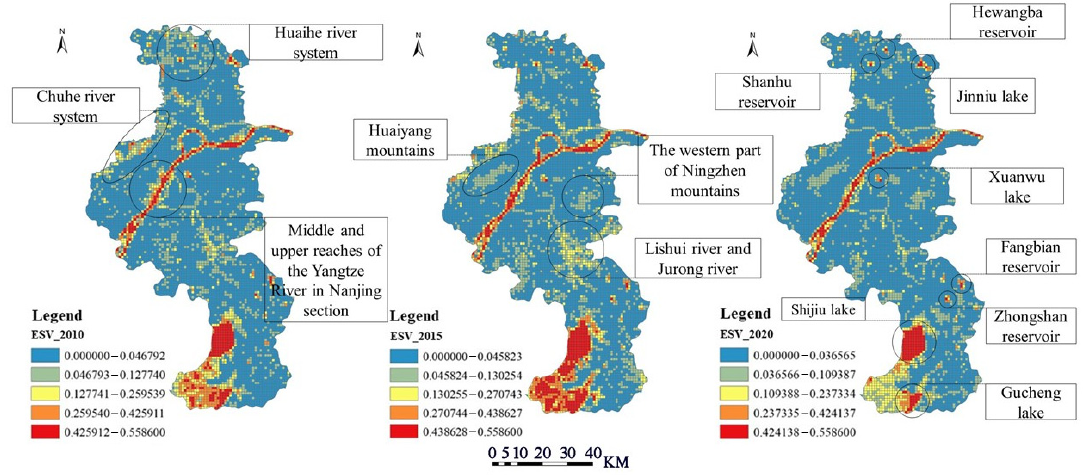
Figure 4. Spatial distribution of grid unit ESV in Nanjing.